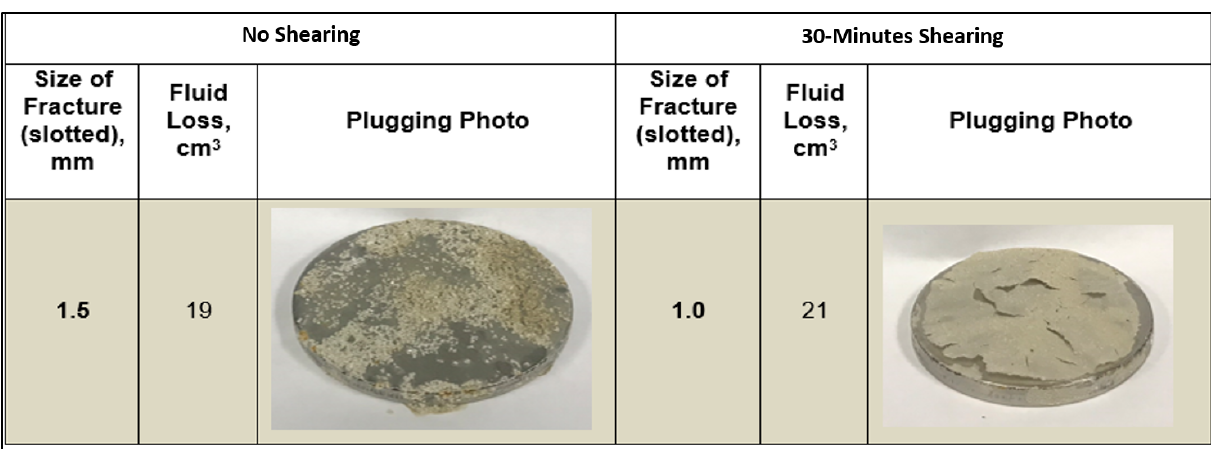
Figure 7. Marble maximum plugged fracture diameter before and after shearing force.